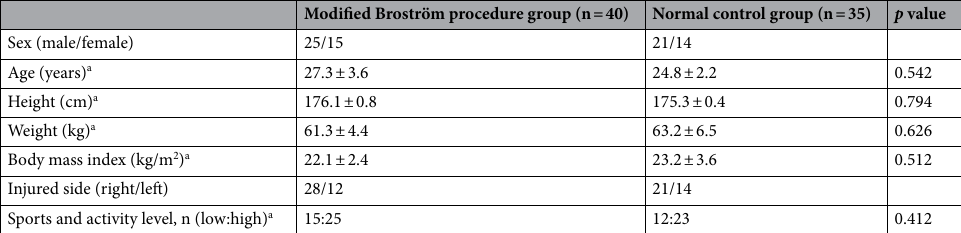
Table 1. Demographic data of subjects in the modified Broström procedure and normal control groups. a Values expressed as mean ± standard